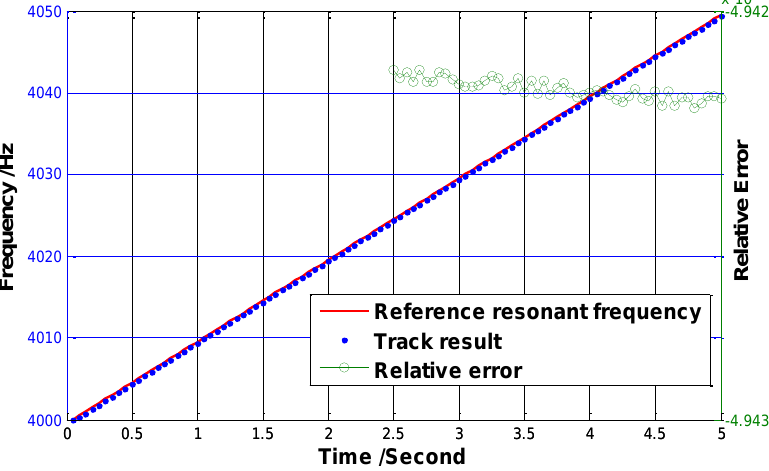
Figure 11. Track results when resonant frequency changes linearly from 4,000 Hz to 4,050 Hz using the track